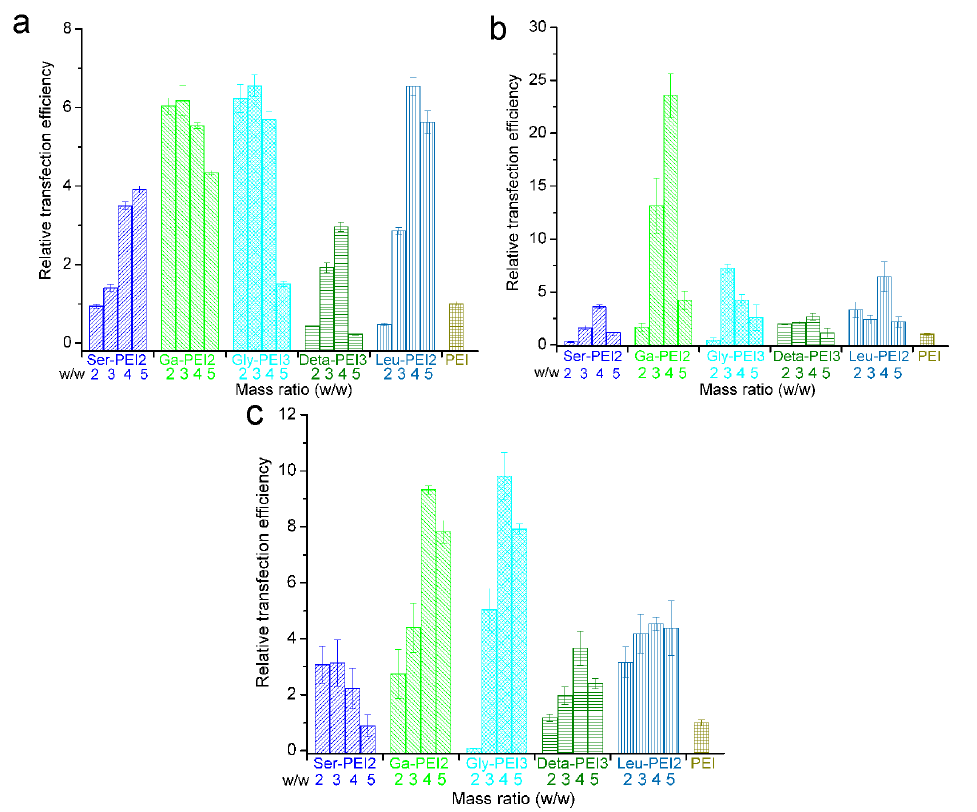
Figure 5. Luciferase gene expression transfected in the presence of 10% serum in different cell lines. ( a ) U-2OS; ( b ) HeLa; ( c ) HEK293. Data represent mean ± SD ( n = 3). 25 kDa PEI ( w / w = 1.4, N/P = 10) was used as control.